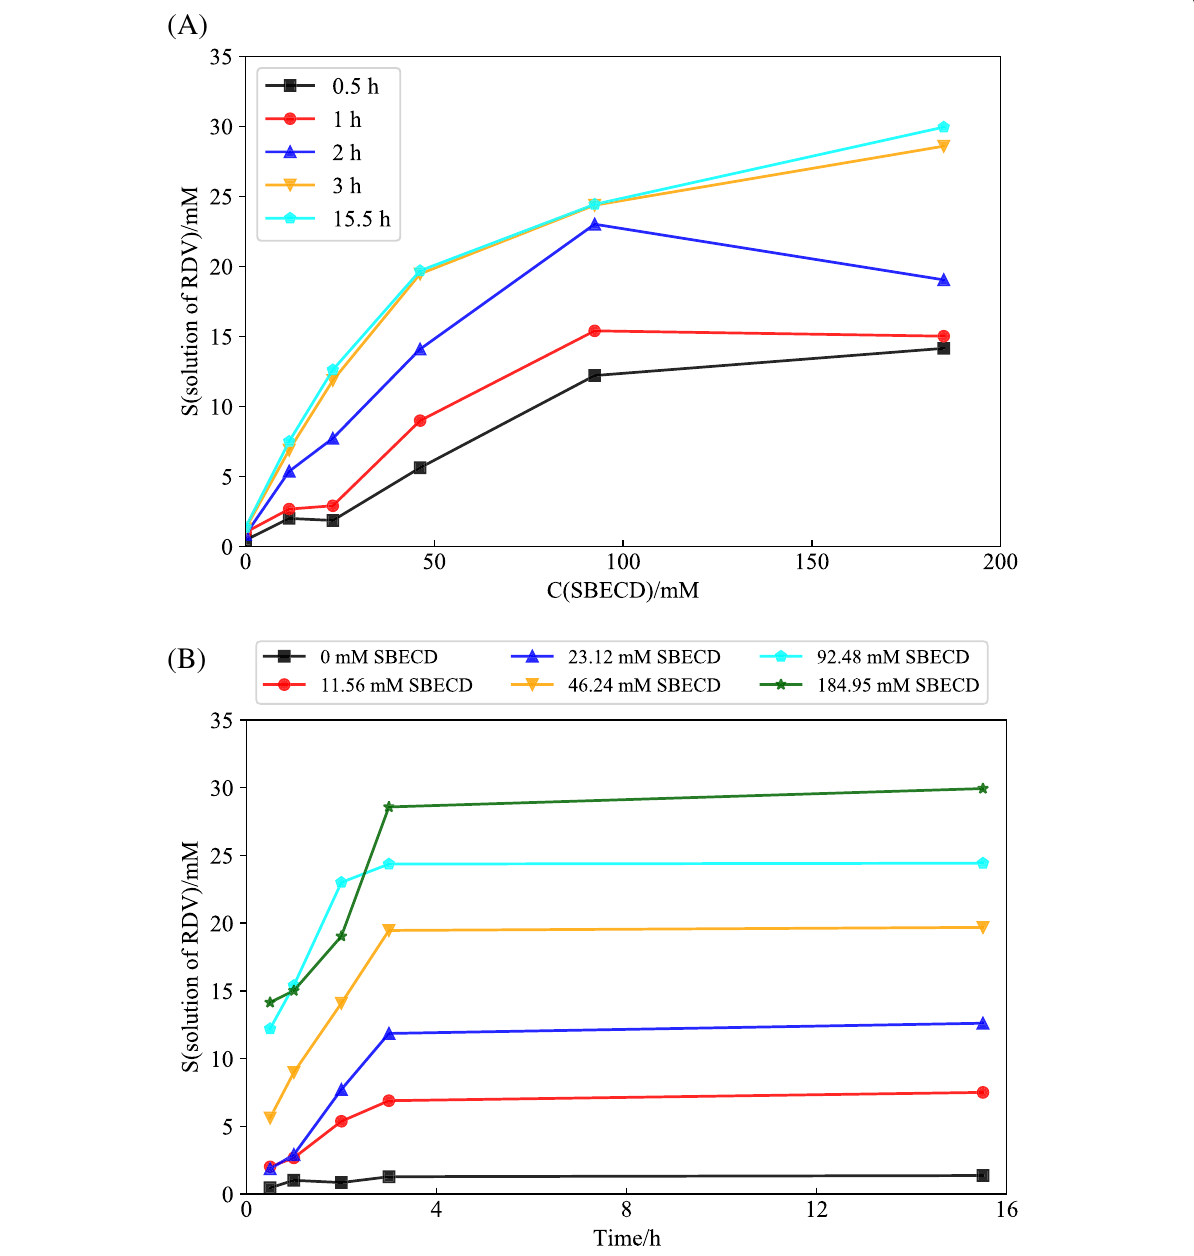
Fig. 1 Effect of incubation time on phase solubility of RDV in SBE‑β‑CD in pH1.7 media at 25 °C: ( A ) S vs C; ( B ) S vs